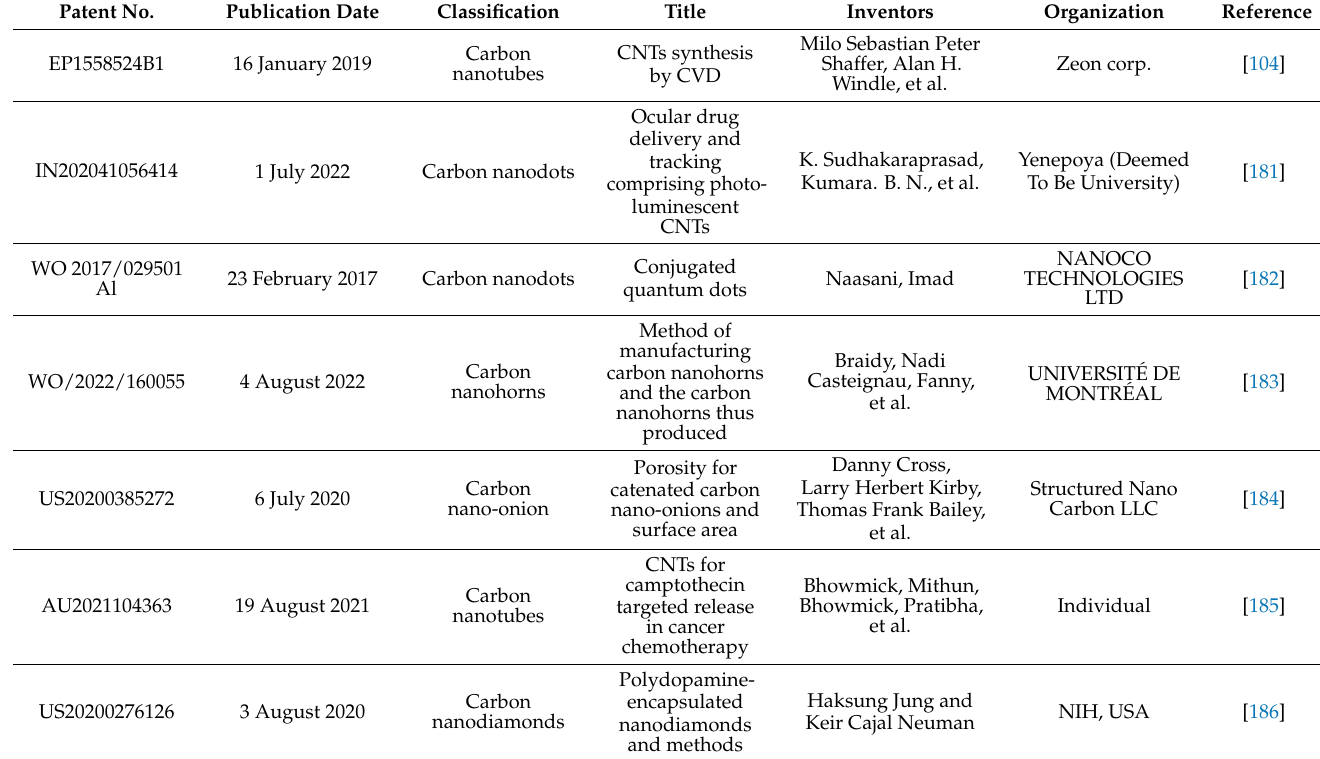
Table 8. List of patents on carbon